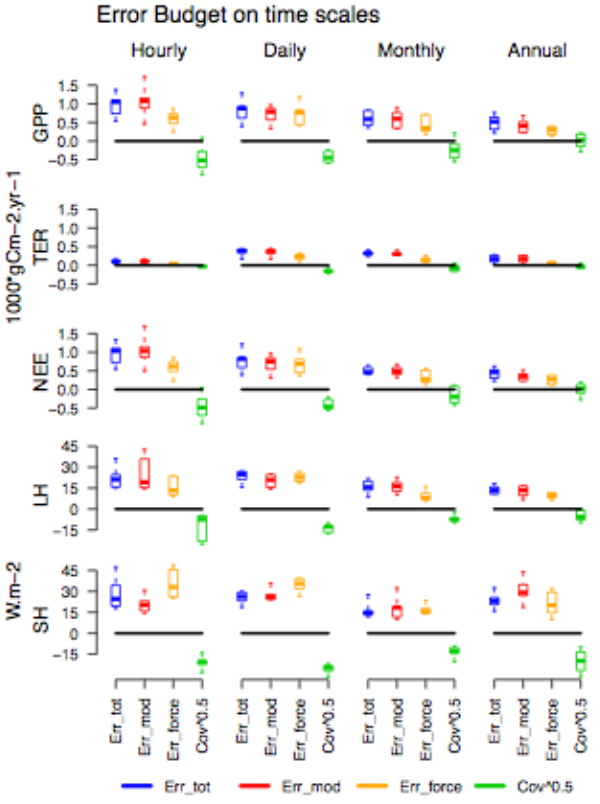
Figure 8 145 Fig. 8. Box plot of error estimation across 6 sites during peak grow- ing season. The bottom and top of the box are the 25th and 75th percentile, respectively, and the band near the middle of the box is the median. The lower and upper ends of the box represent the min- imum and maximum value. Err tot, Err mod and Err force denote total model error, model error and forcing error, respectively. For the reason of plotting, covariance is expressed as the squared abso- lute covariance (cov 0 . 5 ) bearing the sign of covariance. Unit is kg Cm − 2 yr − 1 and Wm − 2 for carbon and water fluxes,